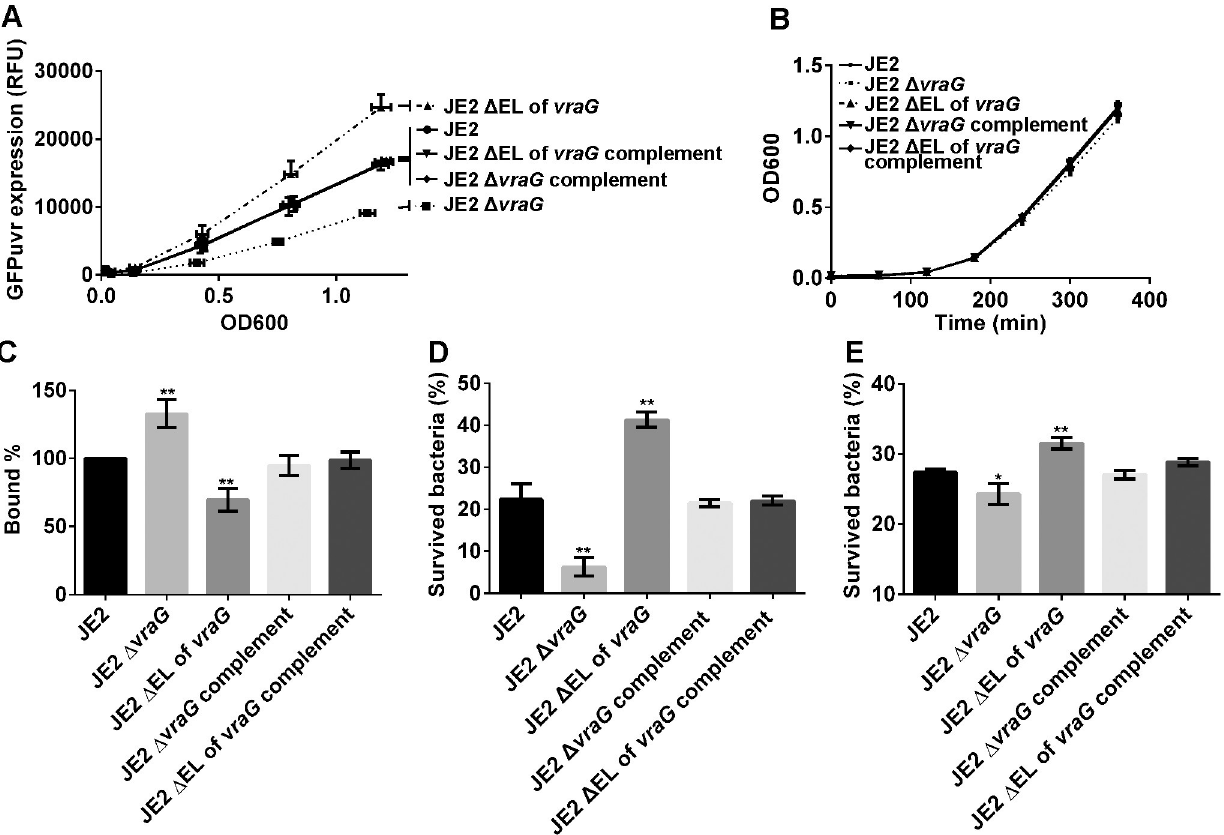
Fig 2. The Δ EL vraG mutant enhances GraS-mediated signaling of HDP. (A) The mprF promoter fusion with GFPuvr reporter assay. (B) Cell growth of assorted vraG mutants and the parent JE2. Fluorescent intensities and OD600 were measured every hour for 6 hours. The data were plotted by fluorescence arbitrary unit (A.U.) with fixed gain at 145 vs. OD 600 with error bars (horizontal: SDs of A.U., vertical: SDs of OD 600 ). The growth curves of the depicted strains were given as OD 600 vs. Time (min) with error bars (SDs). The data were obtained from three independent experiments. (C) Cytochrome c binding assay, (D) LL-37 susceptibility assay, (E) PMN assay were performed as previously described. The asterisks � and �� for C , D and E indicate p < 0.05 and < 0.01, respectively, using Student-t